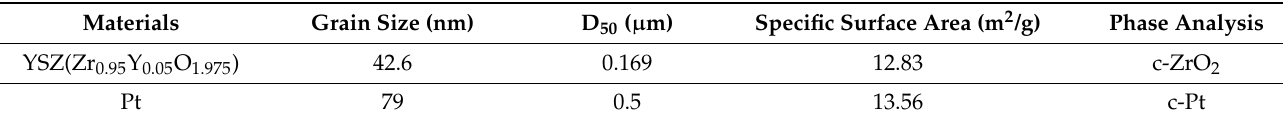
Table 1. Physical properties of YSZ and Pt materials.